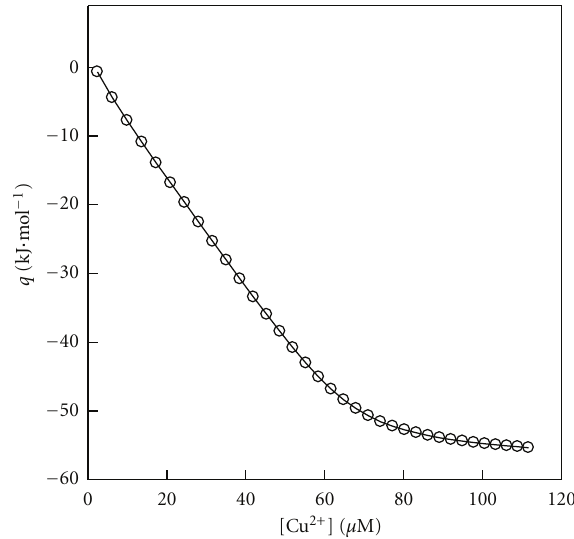
Figure 2: Comparison between the experimental heats (O) at 310 K, for Aβ (1–16) + Cu 2+ interactions and the calculated data (lines) via (1). [Cu 2+ ] values are the concentrations of [Cu(NO 3 ) 2 ] solution in μ